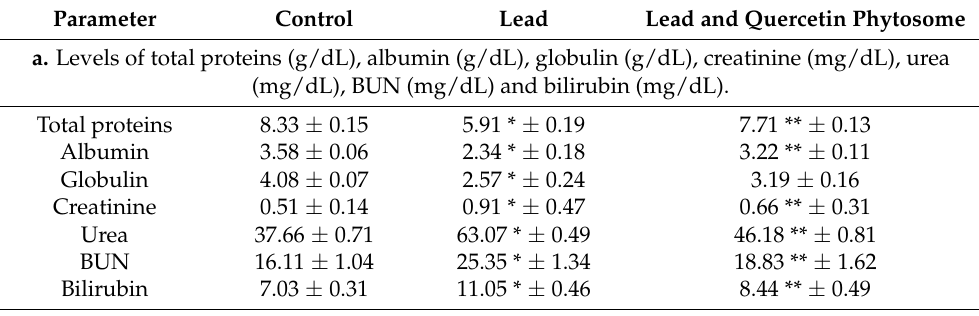
Table 2. Biochemical parameters in rats exposed to lead, and rats exposed to lead and given quercetin phytosome, compared to the untreated control